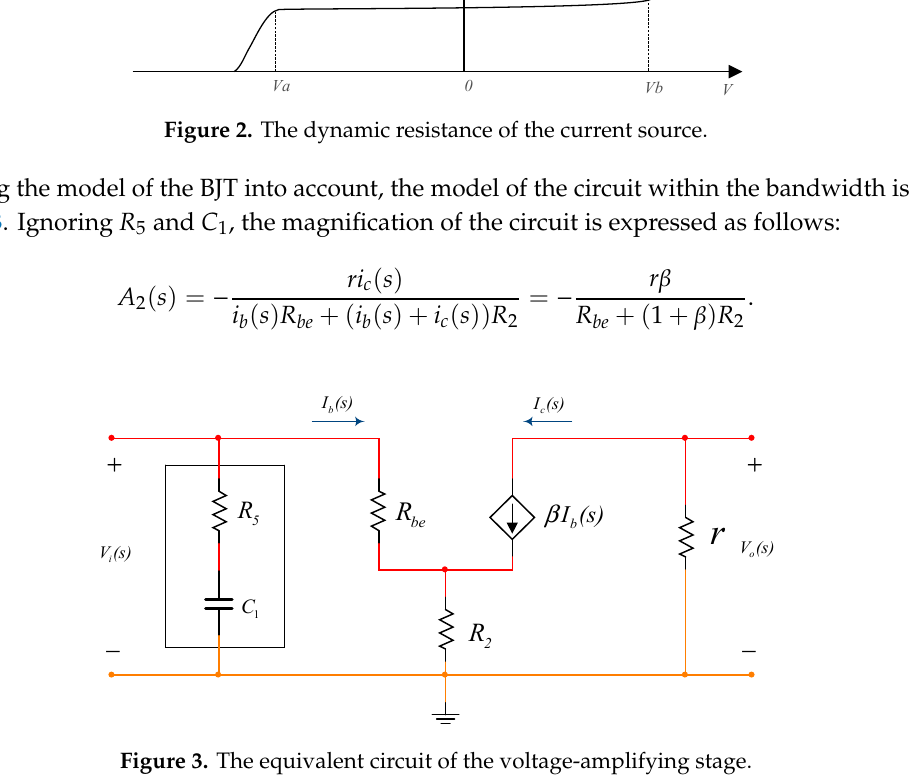
Figure 2. The dynamic resistance of the current source.